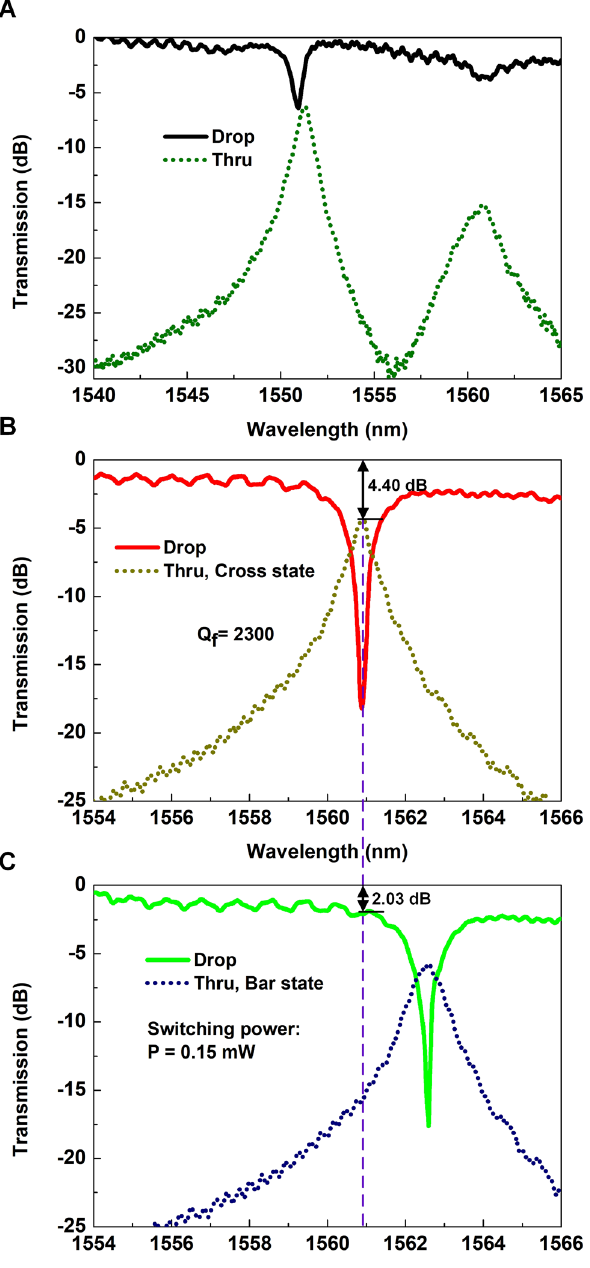
Figure 6: Measured transmission spectra at different states of the fabricated switch.